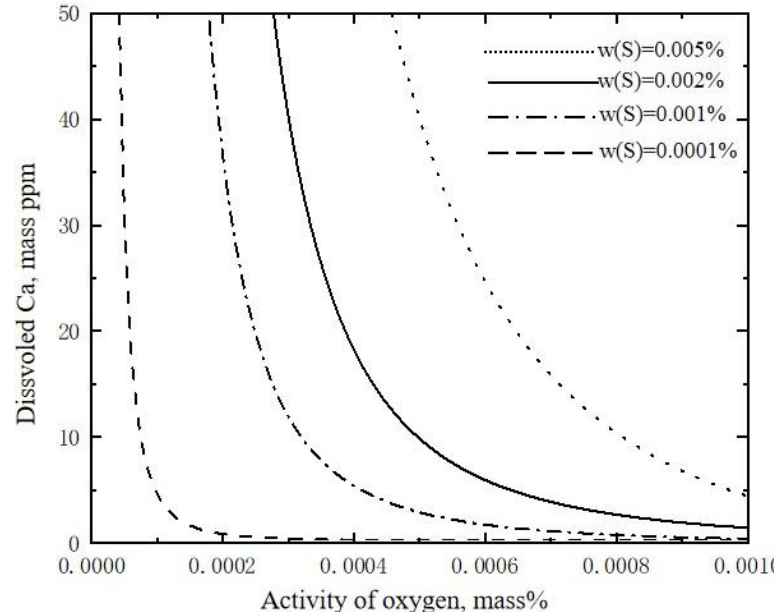
Figure 15. [Ca]–[O] equilibrium curves for the formation of 7Al 2 O 3 · 12CaO under different [S] con- tents.